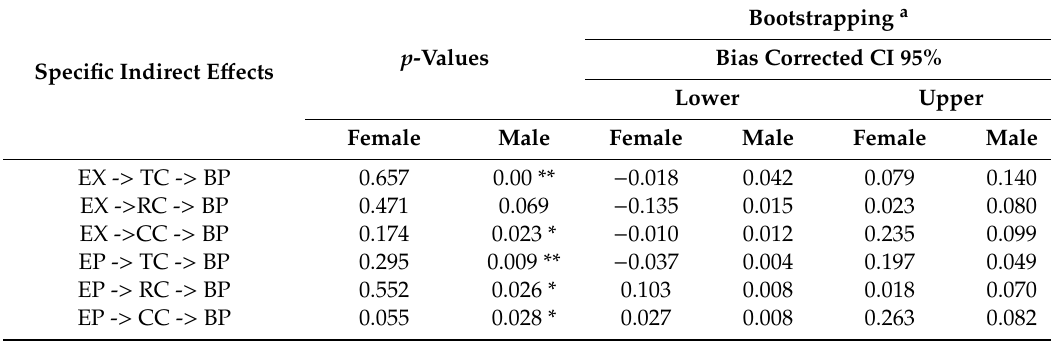
Table 5. Gender di ff erences in the multiple mediation structural model.